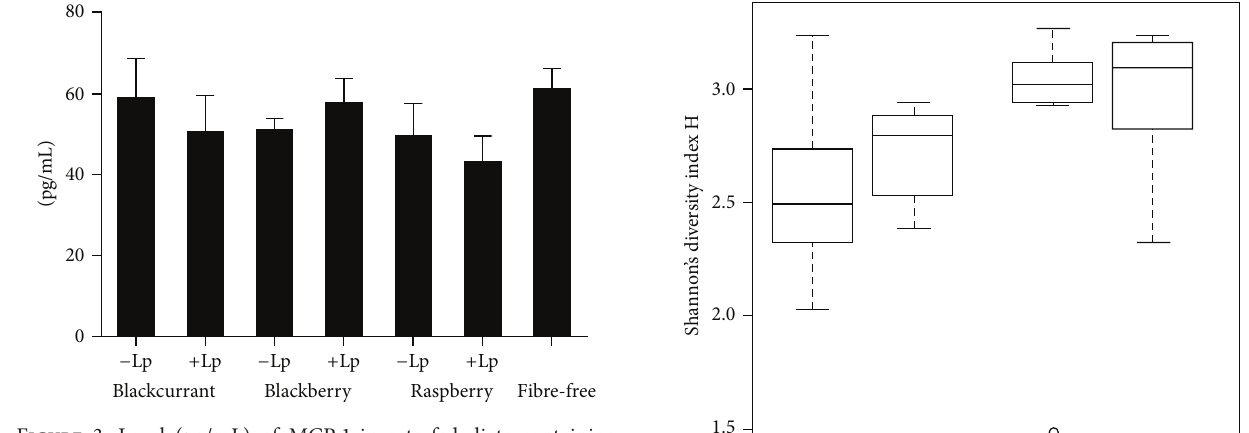
Figure 3: Level (pg/mL) of MCP-1 in rats fed diets containing blackcurrant, blackberry, and raspberry, with the same diets sup- plemented with L. plantarum HEAL19, and a fibre-free group from another study.